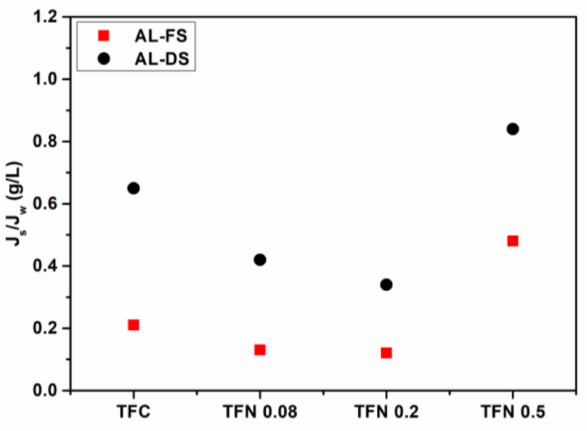
Figure 6. J s / J w values of FO membranes in AL-FS and AL-DS